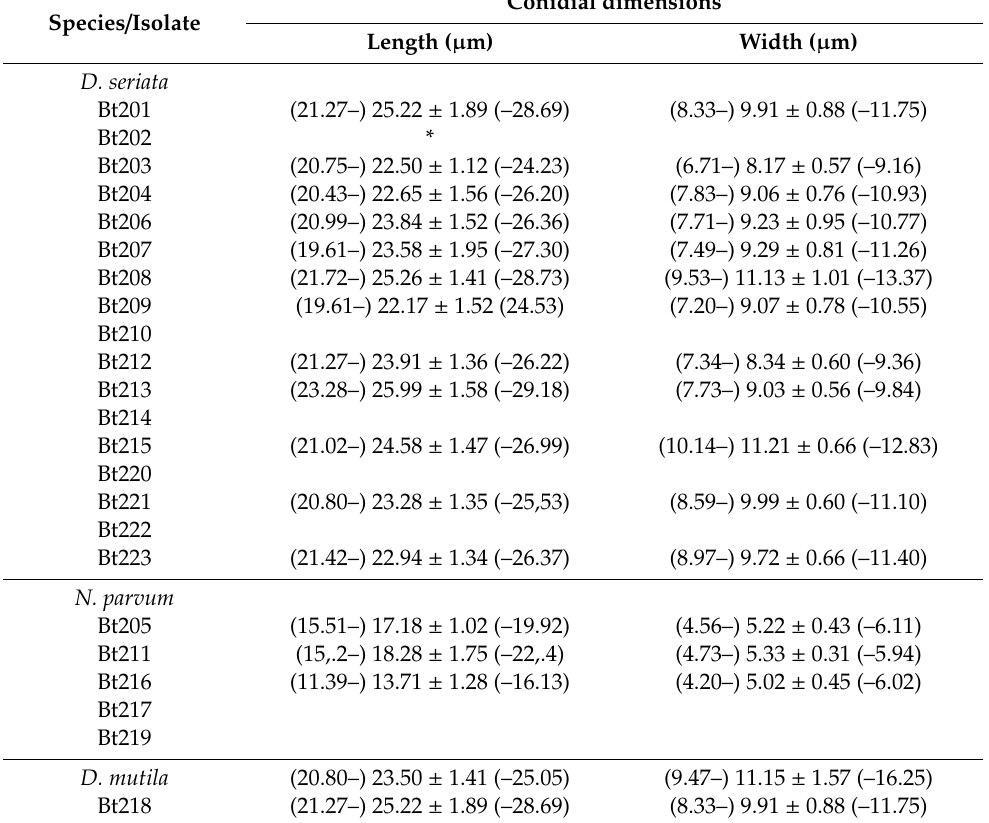
Table 2. Conidial dimension of the Botryosphaeriaceae species under study. Species /